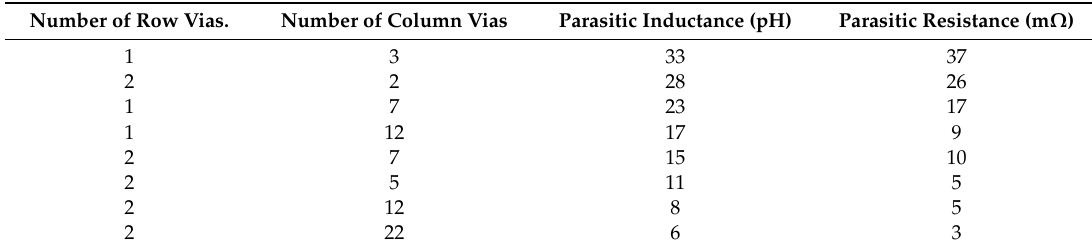
Table 1. Parasitic inductance and resistance of TSV with different sizes. Number of Row